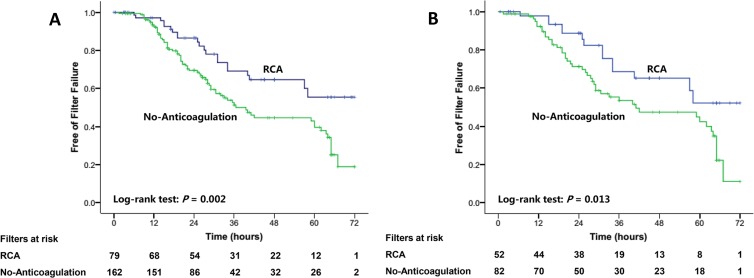
Survival curves of the filters with the use of RCA versus the filters with the use of no-anticoagulation in the original cohort (A) and the matched cohort (B).